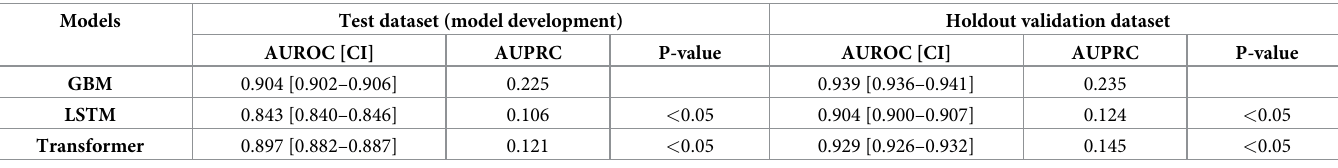
Abbreviations: AUROC, area under the receiver operating curve; AUPRC, area under the precision-recall curve; CI, confidence interval; GBM, gradient-boosting model; LSTM, long short-term